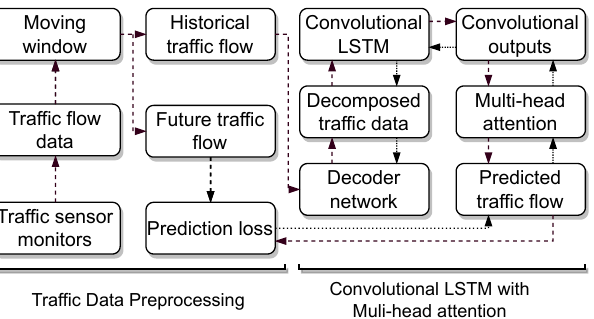
Figure 1. The framework of the convolutional LSTM with a multi-head attention mechanism for traffic flow